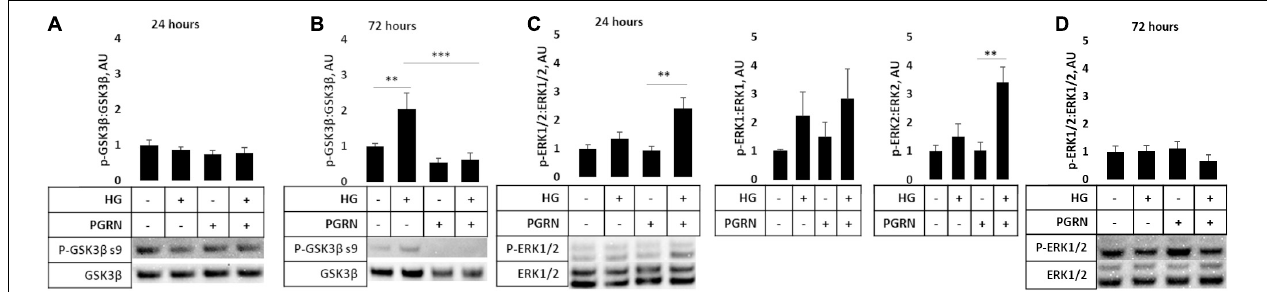
FIGURE 7 | GSK3 β and ERK phosphorylation in cortical neurons due to high glucose and PGRN treatment. Cells were treated with high glucose and PGRN for 24 or 72 h before harvest and western blot analysis. (A,B) GSK3 β phosphorylation at serine nine was unaltered by high glucose or PGRN at 24 h (A) but showed significant change at 72 h (B) . At 72 h, high glucose increased phosphorylation from 1.000 ± 0.078 AU to 2.044 ± 0.445 AU, while PGRN treatment lowered phosphorylation in both control (1.000 ± 0.078 AU to 0.550 ± 0.112 AU) and high-glucose conditions (2.044 ± 0.445 AU to 0.628 ± 0.178 AU). N = 5-6 samples. (C) ERK1/2 phosphorylation at threonine 202/tyrosine 204 increased with simultaneous PGRN and high-glucose conditions from 1.000 ± 0.145 AU to 2.403 ± 0.381 AU at 24 h of treatment. Upon closer analysis, ERK2, but not ERK1, phosphorylation was significantly affected, with ERK2 phosphorylation increasing from 1.000 ± 0.197 AU to 3.401 ± 0.544 AU. N = 3 samples. (D) ERK1/2 phosphorylation at threonine 202/tyrosine 204 was not significantly altered by high glucose or PGRN after 72 h. N = 6 samples. ∗∗ p < 0.01; ∗∗∗ p <